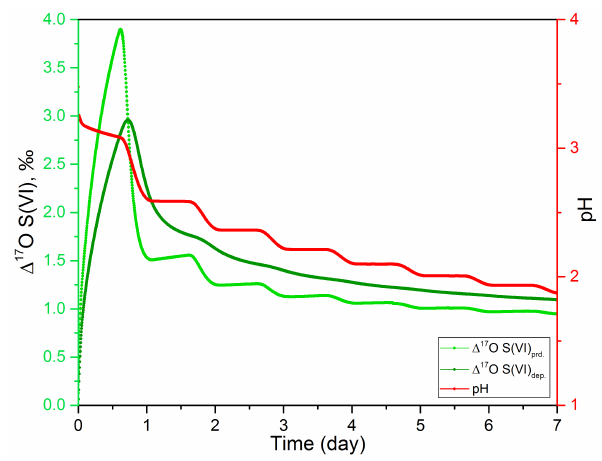
Figure 6. Temporal evolution of (cid:49) 17 O(S ( VI ) ) in produced and de- posited sulfates, and of pH during the S2